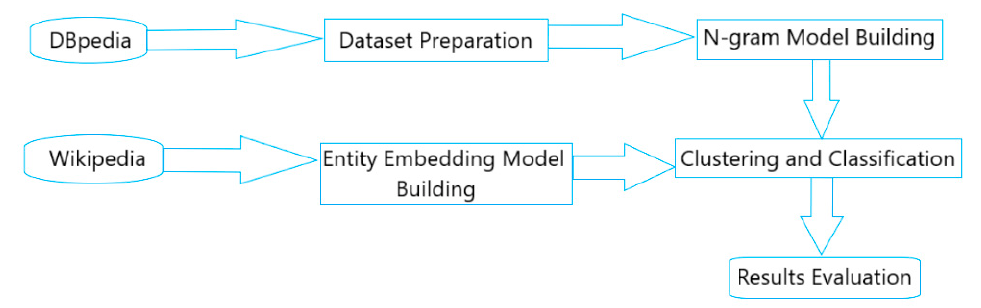
Figure 1 Flowchart of the DBpedia invalid type and entity detection pipeline. Figure 1. Flowchart of the DBpedia invalid type and entity detection